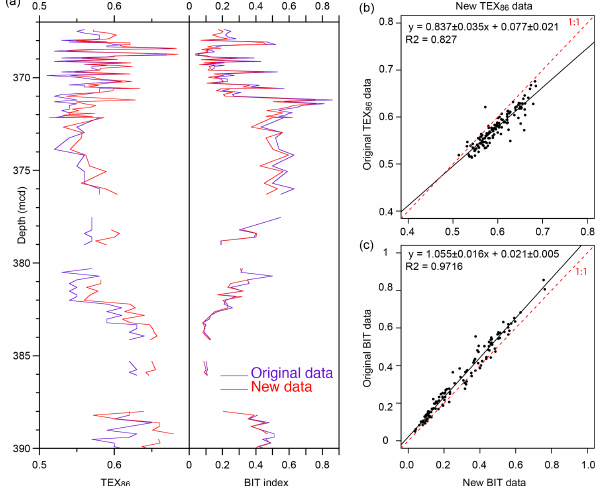
Figure 4. Comparison between BIT index values and TEX 86 for various intervals spanning the upper Paleocene and lower Eocene of ACEX Hole